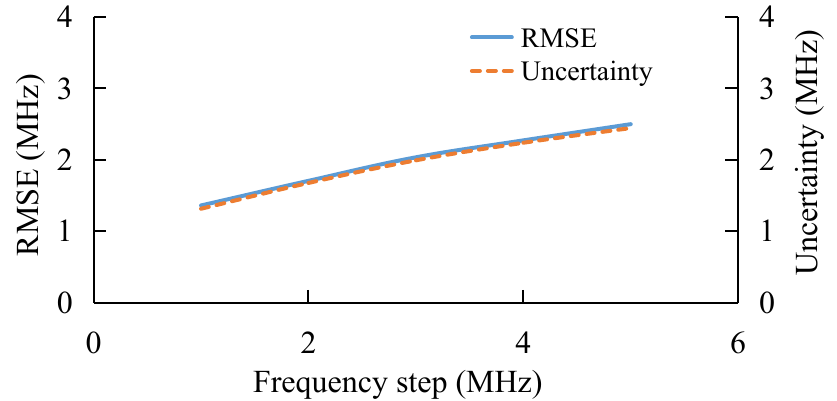
Figure 6. BFS extraction under different frequency step.